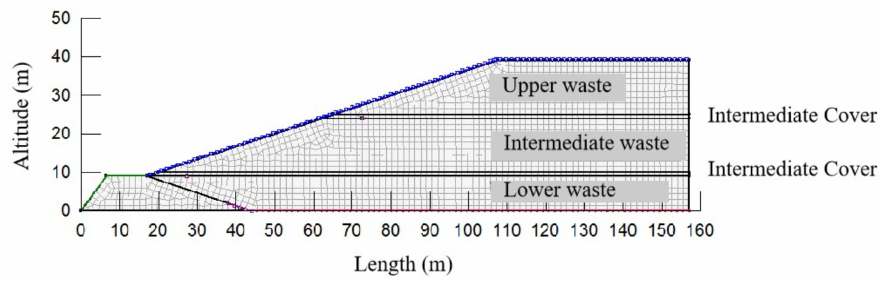
Figure 2. Landfill profile for